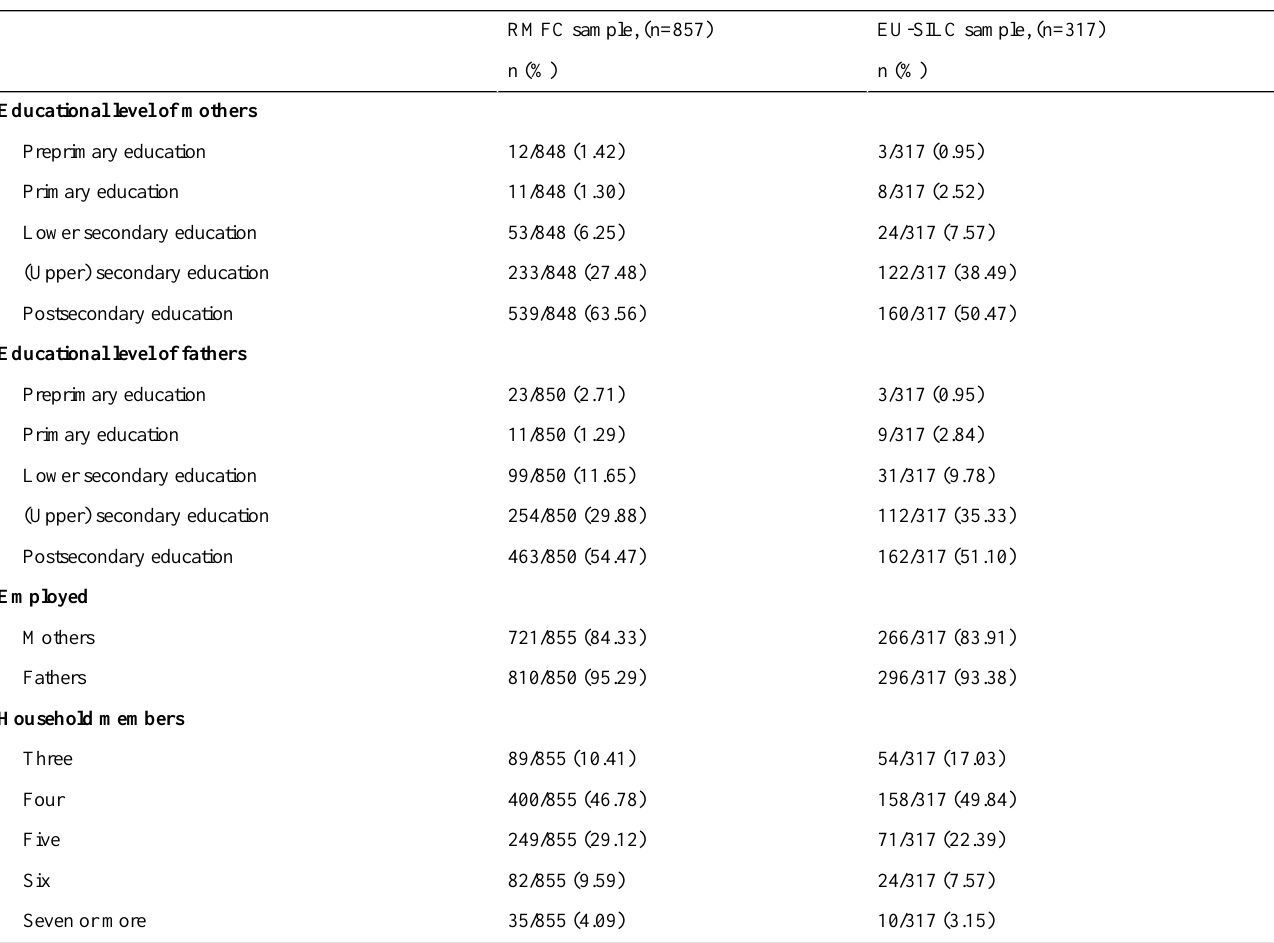
Table 2. Characteristics of the RMFC and the EU-SILC sample.